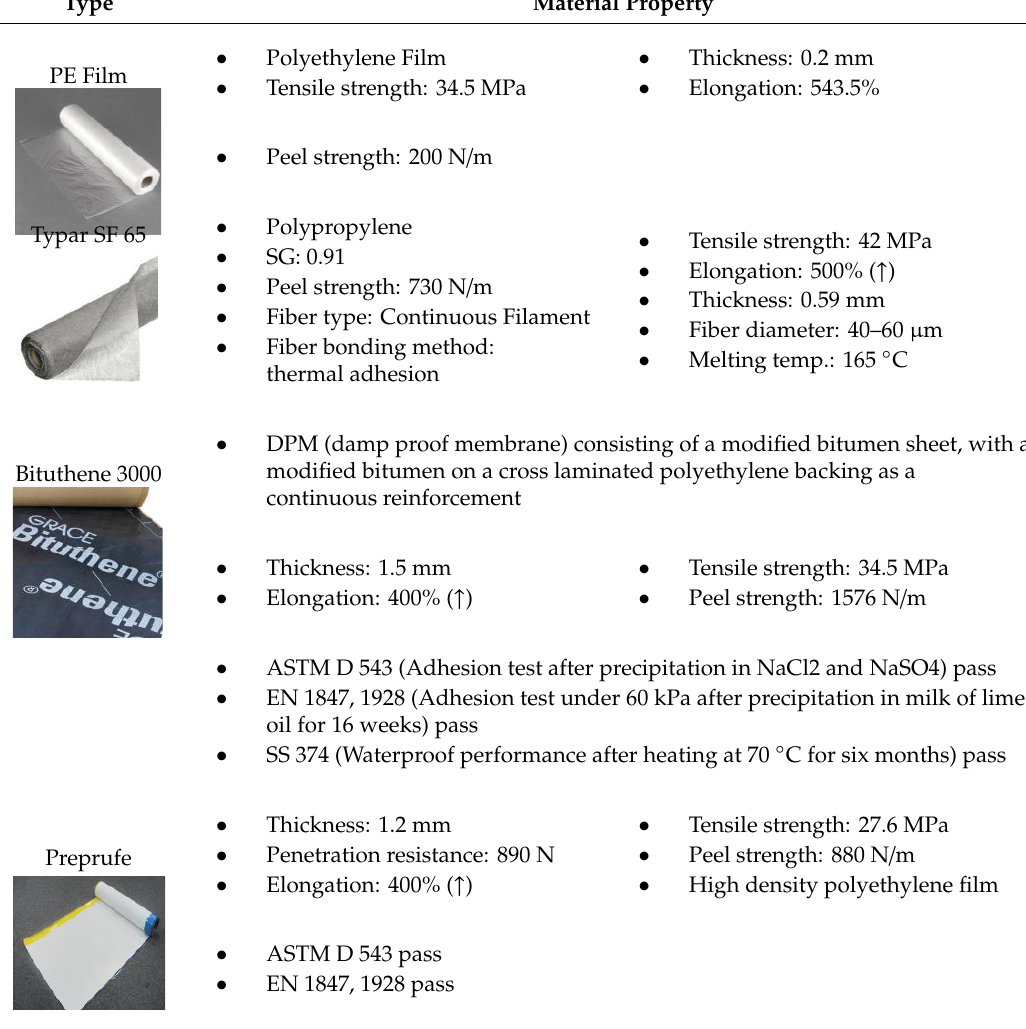
Table 3. Composition of test specimens from protective waterproof